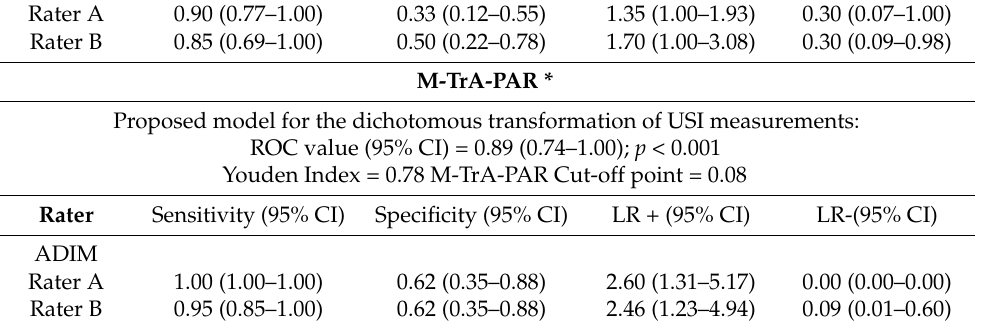
Table 5. Concurrent validity of manual palpation to determine the contraction of the Transversus Abdominis using USI measurements transformed into dichotomous ones as a criterion variable. TrA-CR Proposed model for the dichotomous transformation of USI measurements: ROC value (95% CI) = 0.60 (0.39–0.82); p = 0.33 Youden Index = 0.25 TrA-CR Cut-off point = 1.32 TrA-PAR * Proposed model for the dichotomous transformation of USI measurements: ROC value (95% CI) = 0.86 (0.71–1.00); p = 0.001 Youden Index = 0.73 TrA-PAR Cut-off point = 0.06 Rater Sensitivity (95% CI)